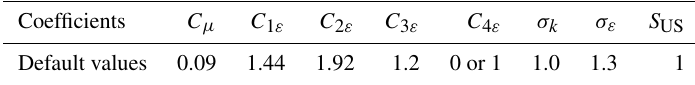
Table 3. Default coefficient values for the k − ε